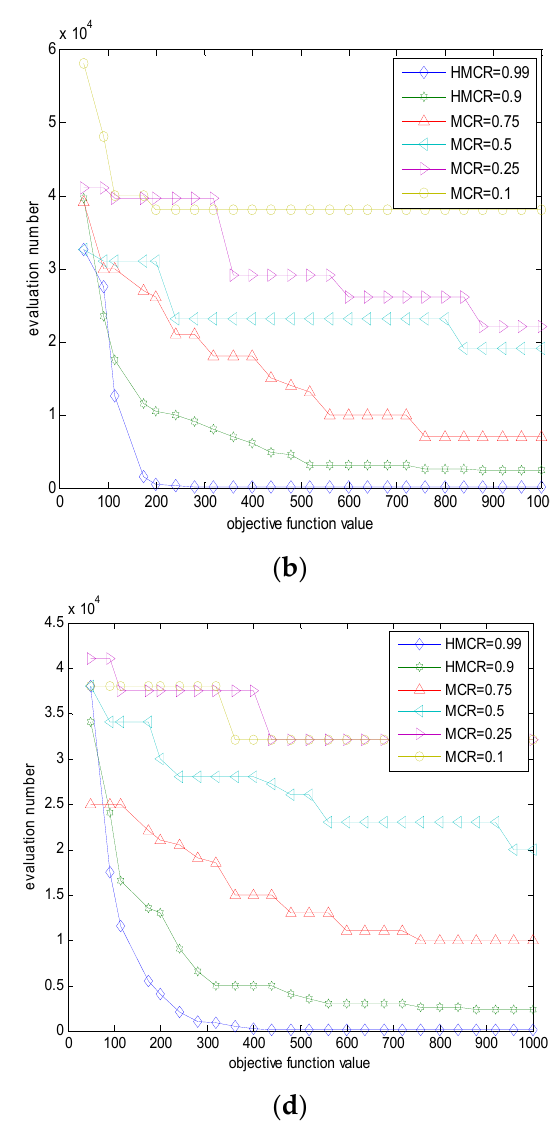
Figure 3. Convergence of OLPDHS with different HMCR values for Sphere and Rastrigin: ( a ) Sphere: [ − 50, 100] ; ( b ) Sphere: [ − 100, 50]; ( c ) Rastrigin: [ − 50, 100]; ( d ) Rastrigin: [ − 100, 50].